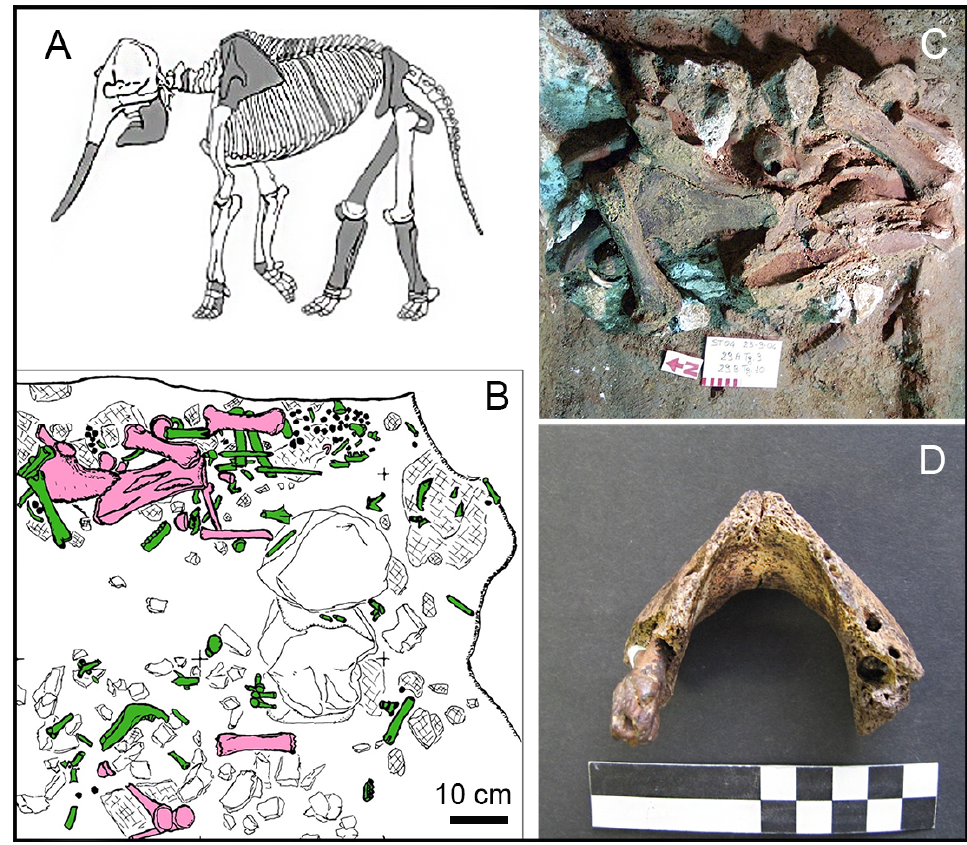
Figure 8. ( A ) Scheme with the position of the bones recovered in the San Teodoro Cave plotted against an elephant skeleton. ( B ) Plan of partially articulated remains of elephant in the β trench (from Ref. [44], modified). ( C ) Detail of the bones on the outcrop. ( D ) A small mandible of a likely Palaeoloxodon, probably not born, found below other elephant bones. Pink: elephant bones; green: ox bones.